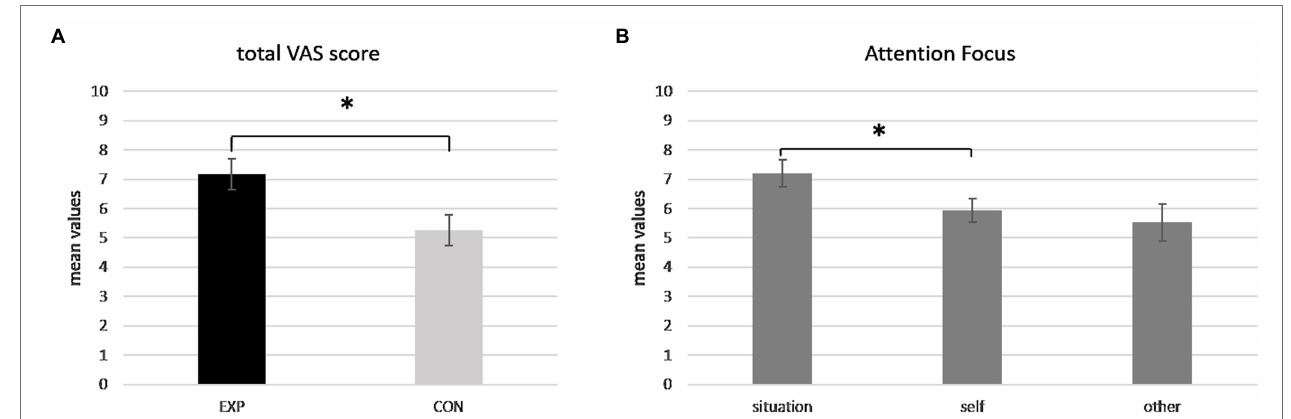
FIGURE 2 | (A,B) Visual Analog Scale (VAS) score. Bar chart shows VAS scores in terms of (A) higher mean values of attention scores for the experimental compared to control group; (B) higher mean values of self-reported attention for the situation compared to the self. For all charts, bars represent ±1 SE; all asterisks mark statistically significant differences, with p ≤